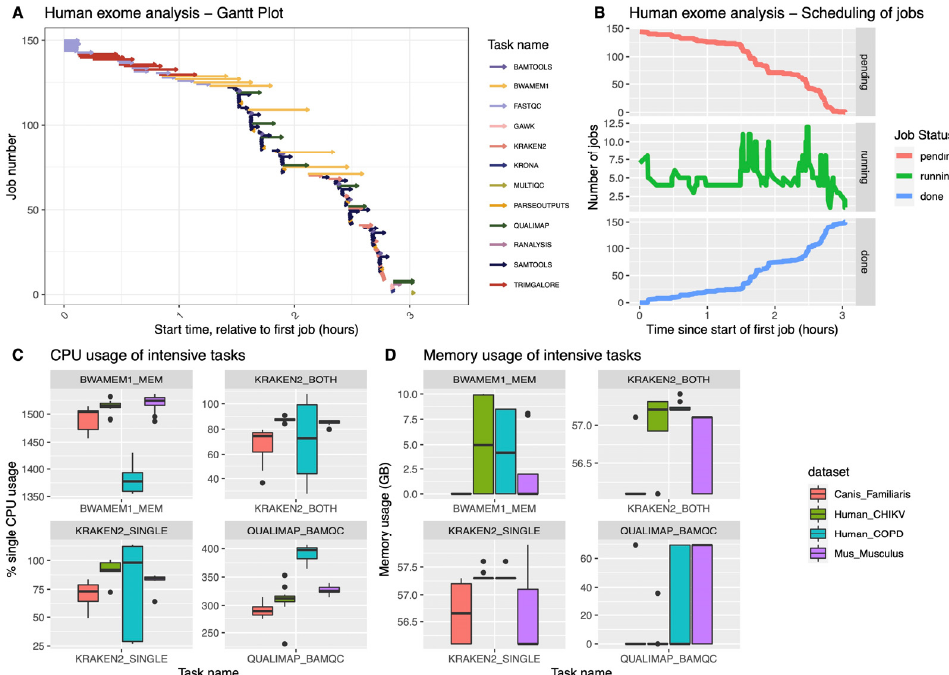
Figure 2. Progress and performance of the pipeline execution. The figure illustrates the execution timeline and the performance of key steps of the pipeline: ( A ) Gantt plot of the analysis of the human COPD dataset: each arrow indicates the start and the end of the task; the colour code represents the category of the analysis or the main software used in that step; ( B ) The plot represents the progress of the analysis in a local HPC cluster, with each panel representing the current status of each task at the corresponding time point; ( C ) The whiskers plot represents the CPU usage during the analysis of four of the test datasets, for tools requiring the most resources in the pipeline: “single” and “both” in the plot refer respectively to those reads with only one unmapped mate in the pair, and those reads where both mates are unmapped; ( D ) Similarly to plot ( C ), the graphical representation shows the memory consumption of the four intensive steps we selected.